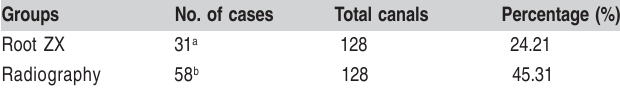
Table 4 – Number of cases in which the electronically and radiographically measured WL fell between scores 0 and